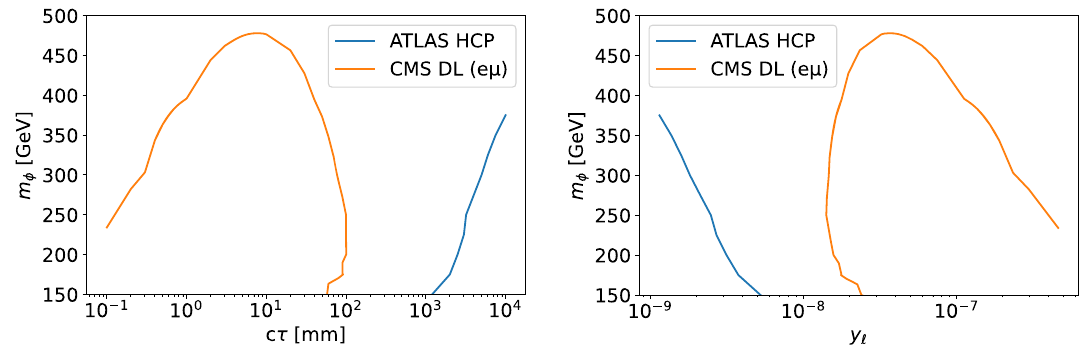
Fig. 5 Upper limits in the lifetime-mass plane (left) and coupling-mass plane (right) of the LLP scalar φ . We do not get limits from the disappearing track search due to a veto on leptons in the event